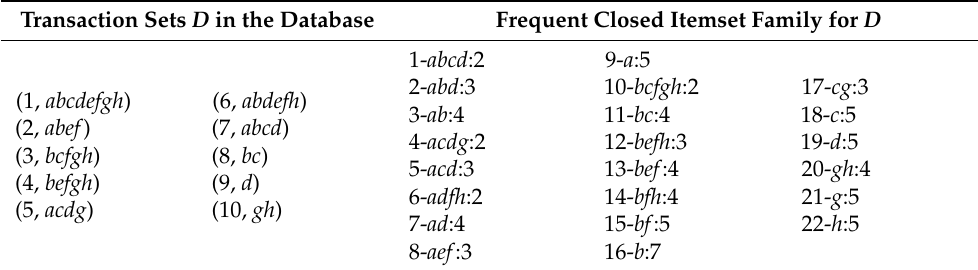
Table 2. Examples of the transaction sets and the derived frequent closed itemsets. Transaction Sets D in the